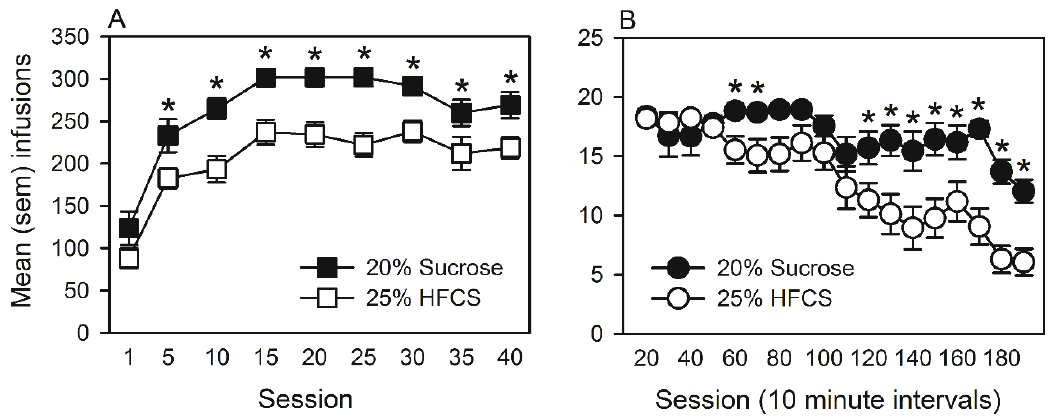
Figure 4. ( A ) Mean (SEM) infusions obtained on a fixed ratio one schedule of reinforcement by rats that self-administered isocaloric infusions of 25% high fructose corn syrup (HFCS) or 20% sucrose. * Significant difference between groups. ( B ) Mean (SEM) infusions of 25% HFCS and 20% sucrose obtained over time (ten-minute intervals) within self-administration Session 20. * Significant difference between groups.